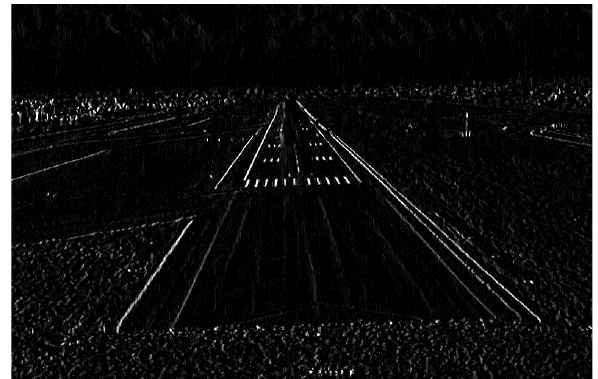
Figure 3. Image of the runway after convolution with the left border marking detection kernel ! markings, threshold marking and touchdown zone marking an